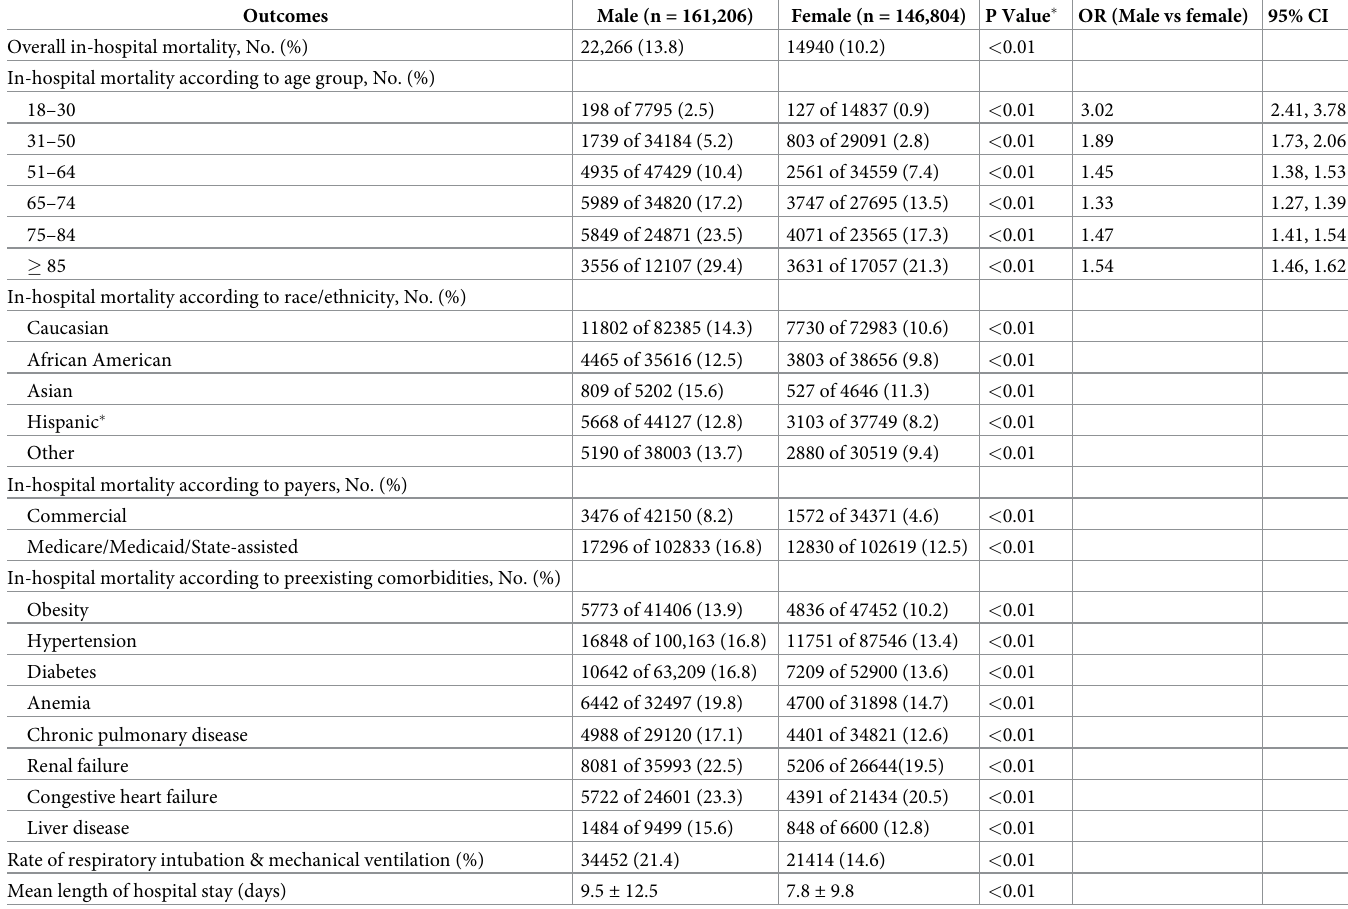
Table 2. Outcomes of male vs female adults with